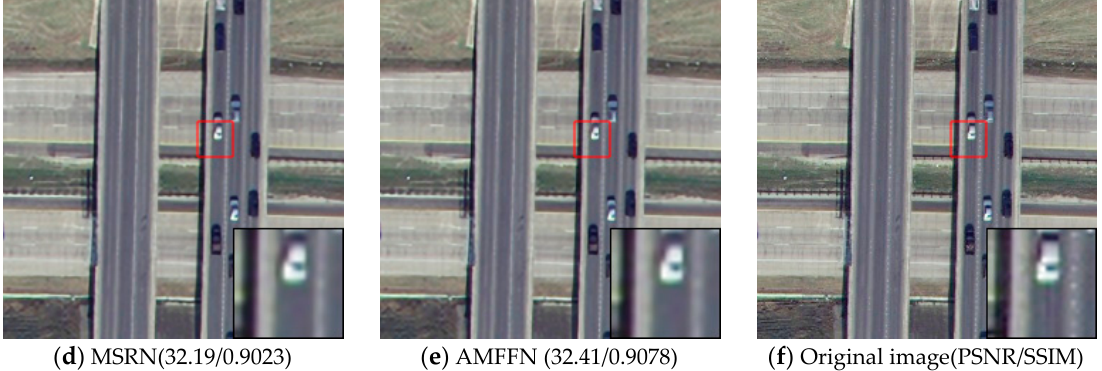
Figure 9. Results of road scenes in UC dataset of different methods with scale factor ×2.